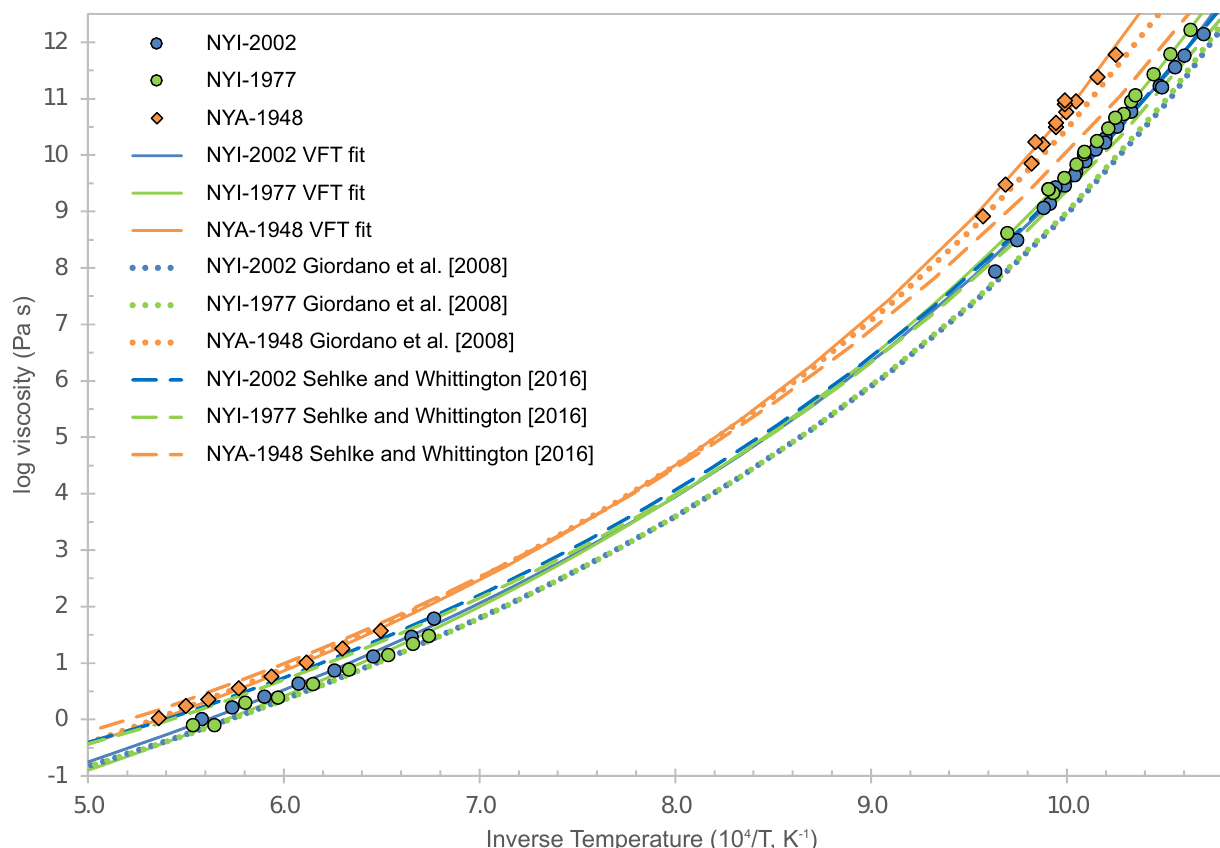
Figure 5: Arrhenian diagram plotting viscosities for the bulk remelted material. Circles and diamonds represent measured Nyiragongo and Nyamuragira data respectively. Solid curves are data from Table 3 fit using models from Vogel [1921]. Dotted lines are predictions of the model from Giordano et al. [2008] and dashed lines